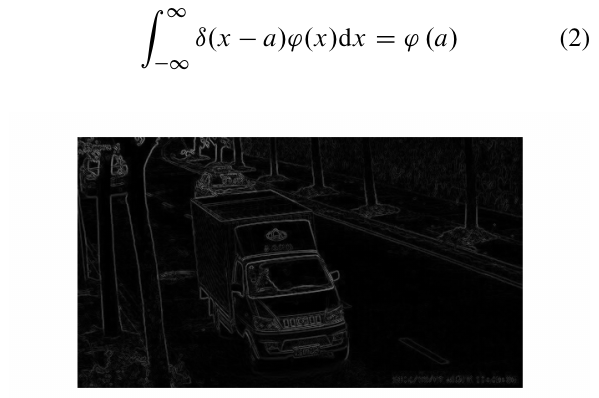
Fig. 2 Gradient of grayscale